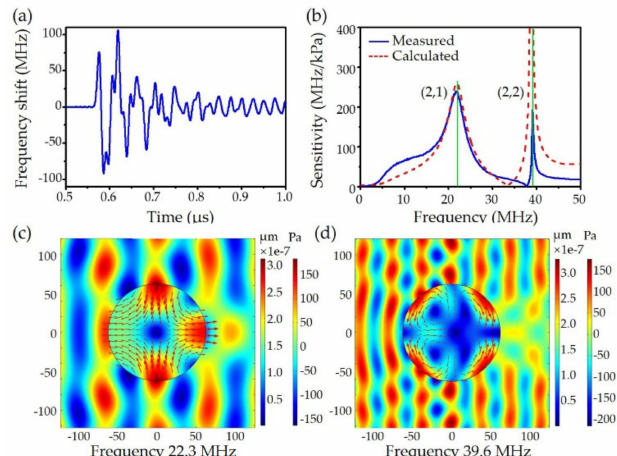
Figure 5. Frequency response of the fiber laser ultrasound sensor. ( a ) Transient response to a pulsed plane wave; ( b ) measured and calculated frequency responses; and ( c ) and ( d ) calculated displacement of the excited fiber vibration at the (2, 1) and (2, 2)